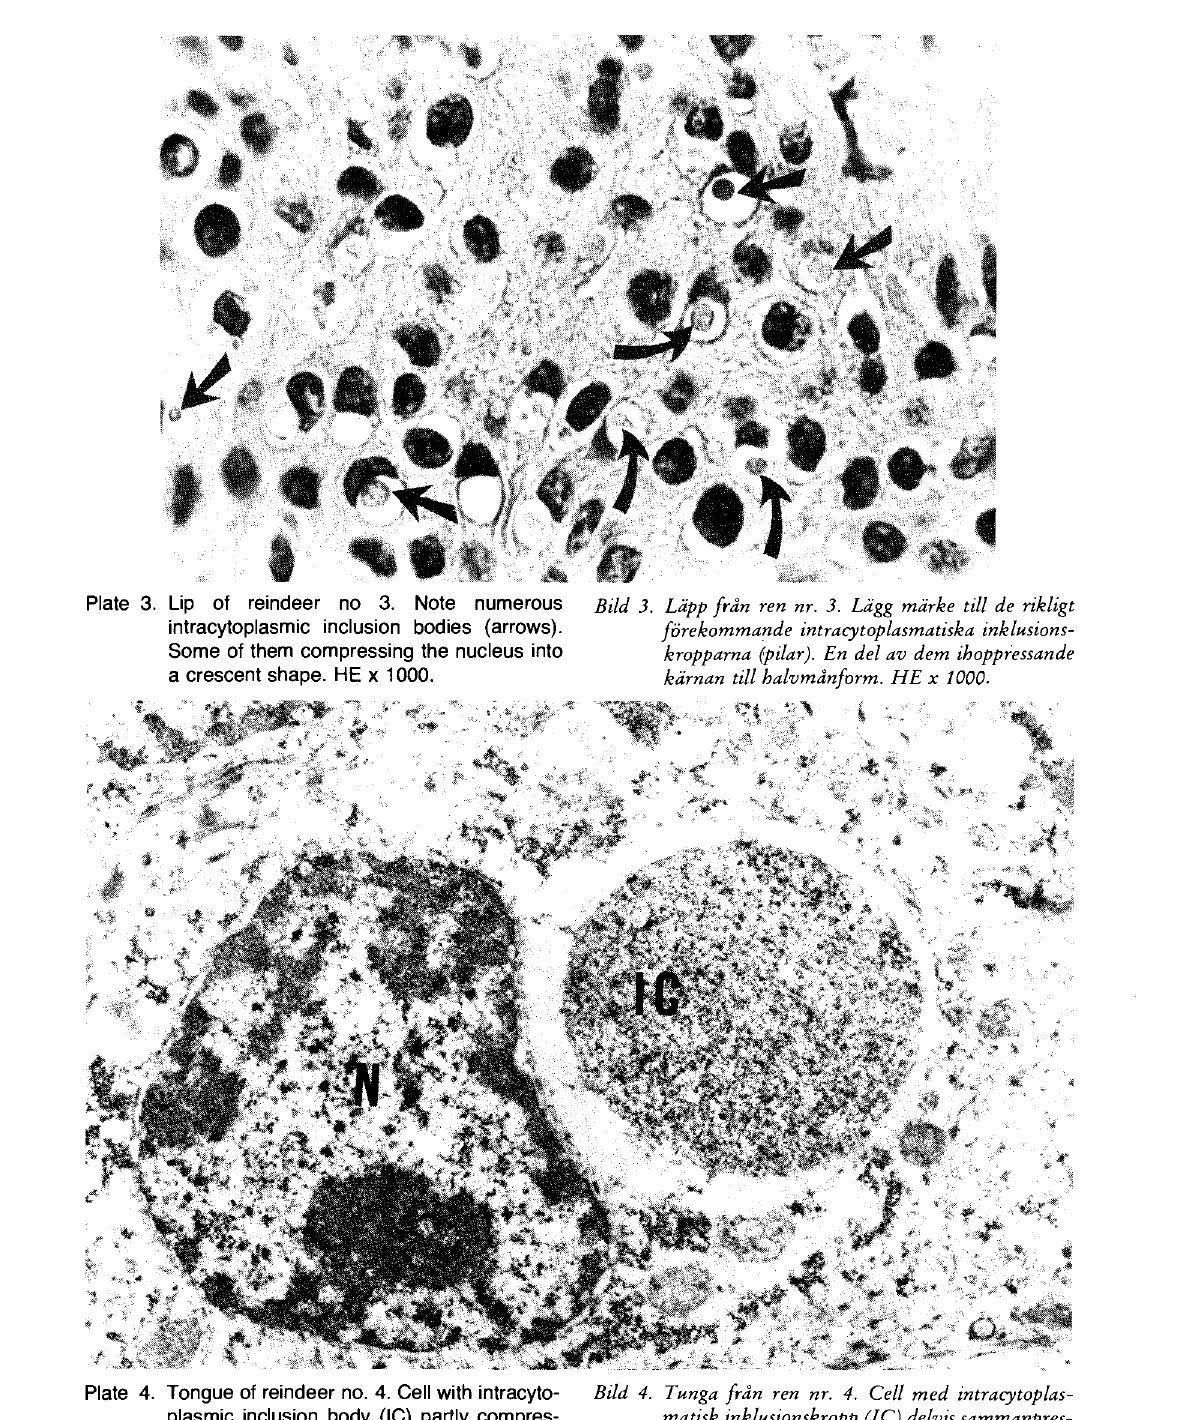
sande kàrnan (N). x